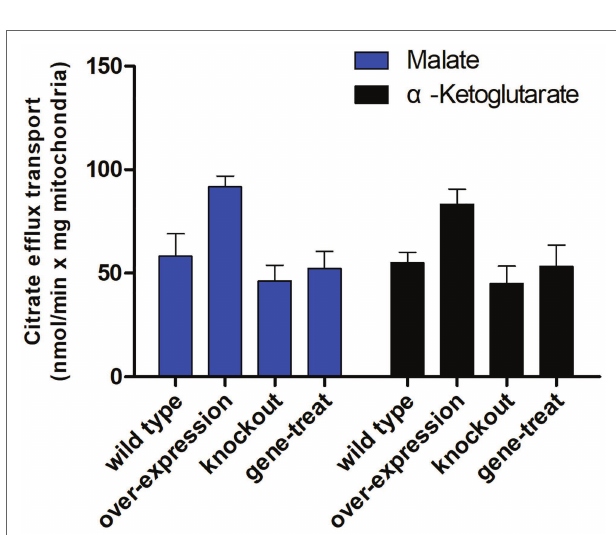
FIGURE 6 | Mitochondrial transport activity of ct -transformants. Mitochondrial transport efficiency were represented of mitochondria from the wild-type transformants, overexpressed, knockout, and gene repair, respectively. Mitochondria were preloaded with 0.01 mM [ 14 C]citrate. Blue and black columns were substrates (10 mM malate and 20 mM α -ketoglutarate, respectively) outside of mitochondria. Error bars represent SDs ( n =